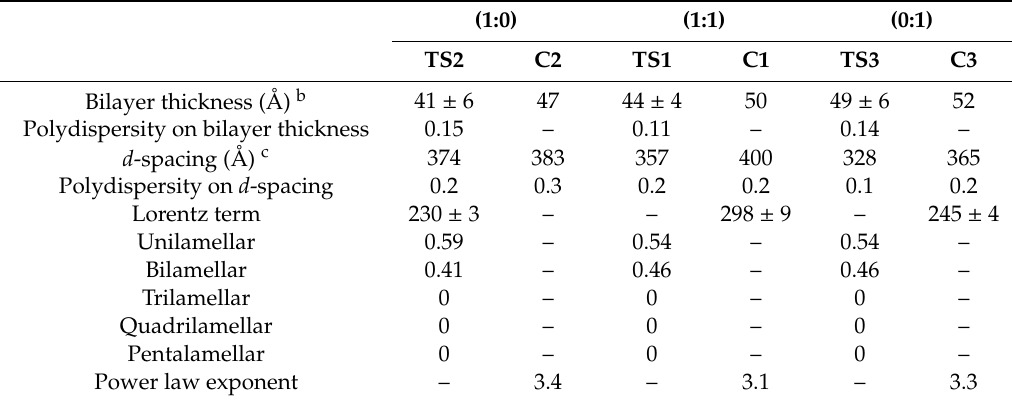
Table 3. Model fitted parameters for the SANS profiles at 298 K of ternary systems (TS1–TS3) a and aqueous creams (C1–C3) containing 4% w / w emulsifier concentration and a 1:1, 1:0 or 0:1 ratio of hexadecanol:octadecanol